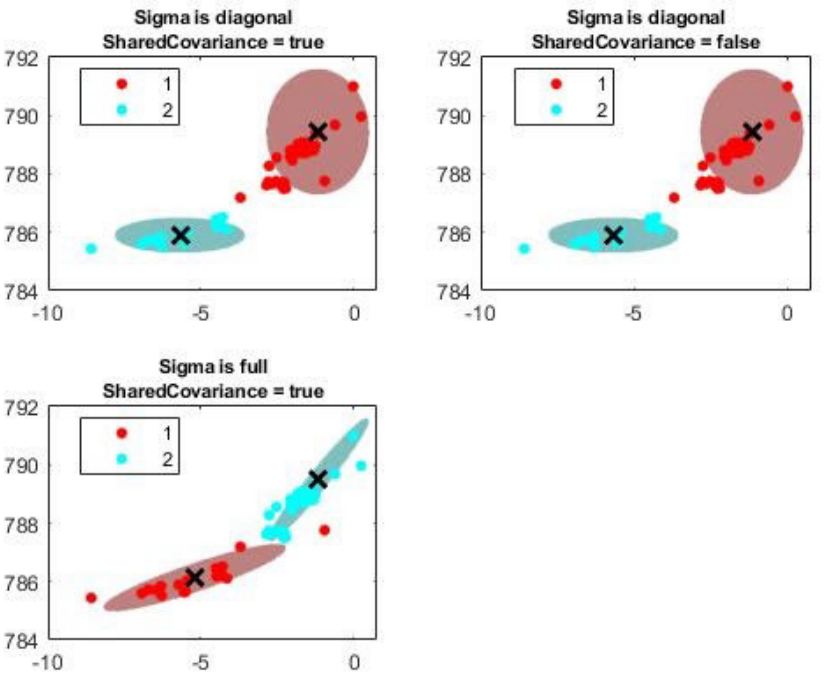
Figure 3: Sigma distribution with diagonal and full covariance matrices